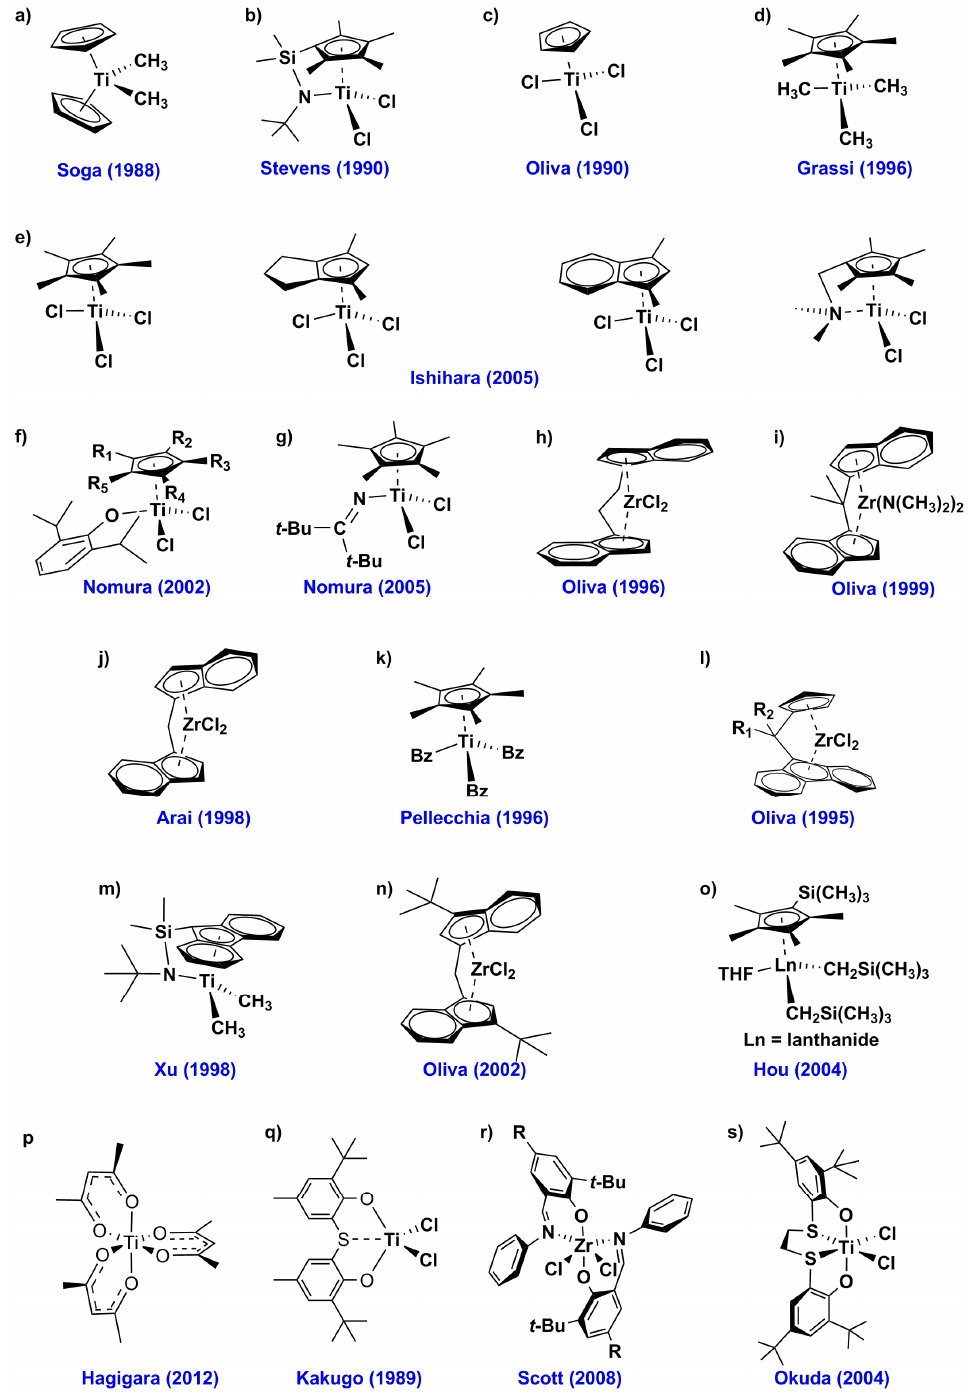
Figure 1. Complexes for ethylene–styrene copolymerization.